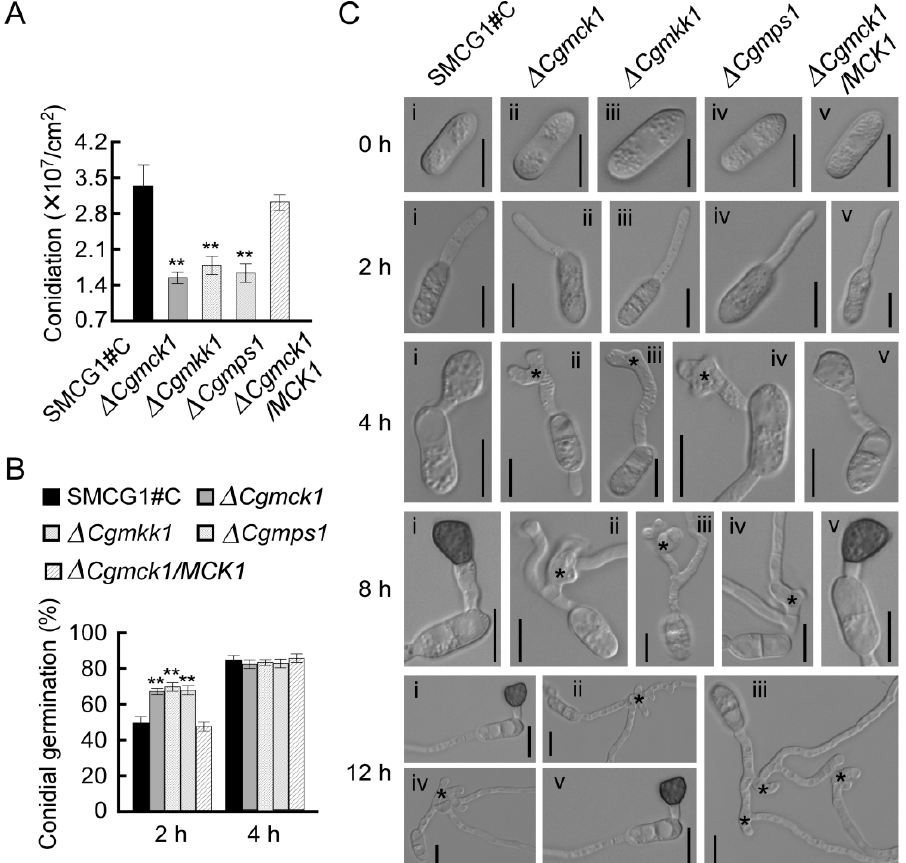
Figure 4. CgMck1 involving in sporulation, conidial germination, and appressorium development. ( A ) Sporulation of the wild type SMCG1#C, ∆ Cgmck1 , ∆ Cgmkk1 , ∆ Cgmps1 , and the complemented strain ∆ Cgmck1 / MCK1 cultured in CMC medium for 48 h. Error bars represent the SD, and asterisks indicate statistically significant differences ( p < 0.01). ( B ) Conidial germination rate of the wild type SMCG1#C, ∆ Cgmck1 , ∆ Cgmkk1 , ∆ Cgmps1 , and the complemented strain calculated after inoculation onto glass slides for 2 h and 4 h, respectively. Error bars represent the SD form the means, and asterisks wild type SMCG1#C (i), ∆ Cgmck1 (ii), ∆ Cgmkk1 (iii), ∆ Cgmps1 (iv), and the complemented strain (v)